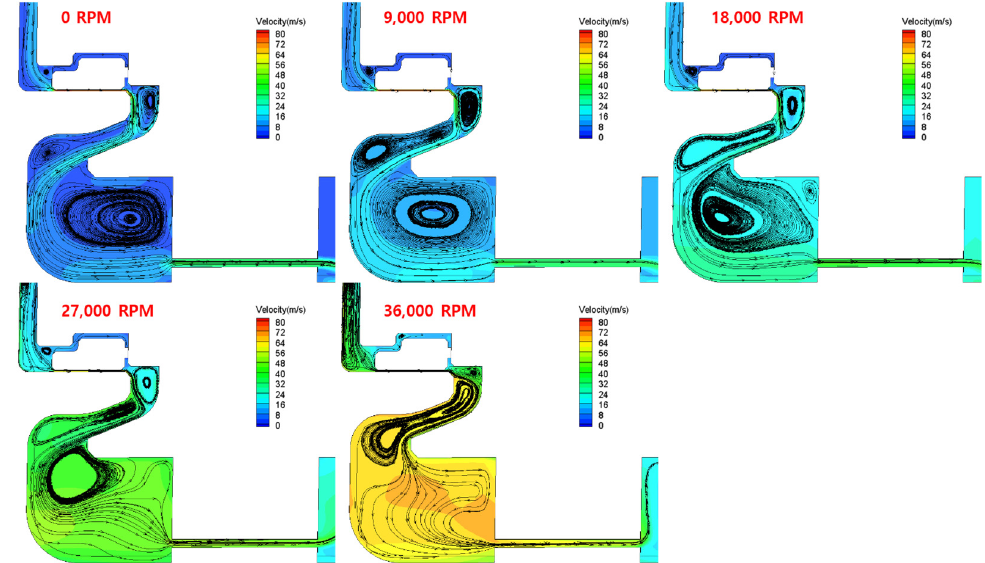
Figure 11. Velocity (m/s) and streamline distributions with rotating speed variation.